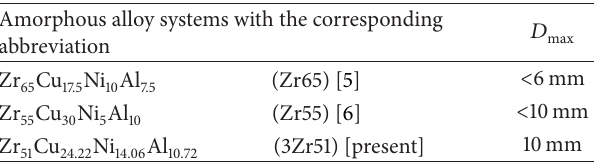
Table 2: The critical sizes ( 𝐷 max ) in our lab for previously reported Zr-based BMGs.